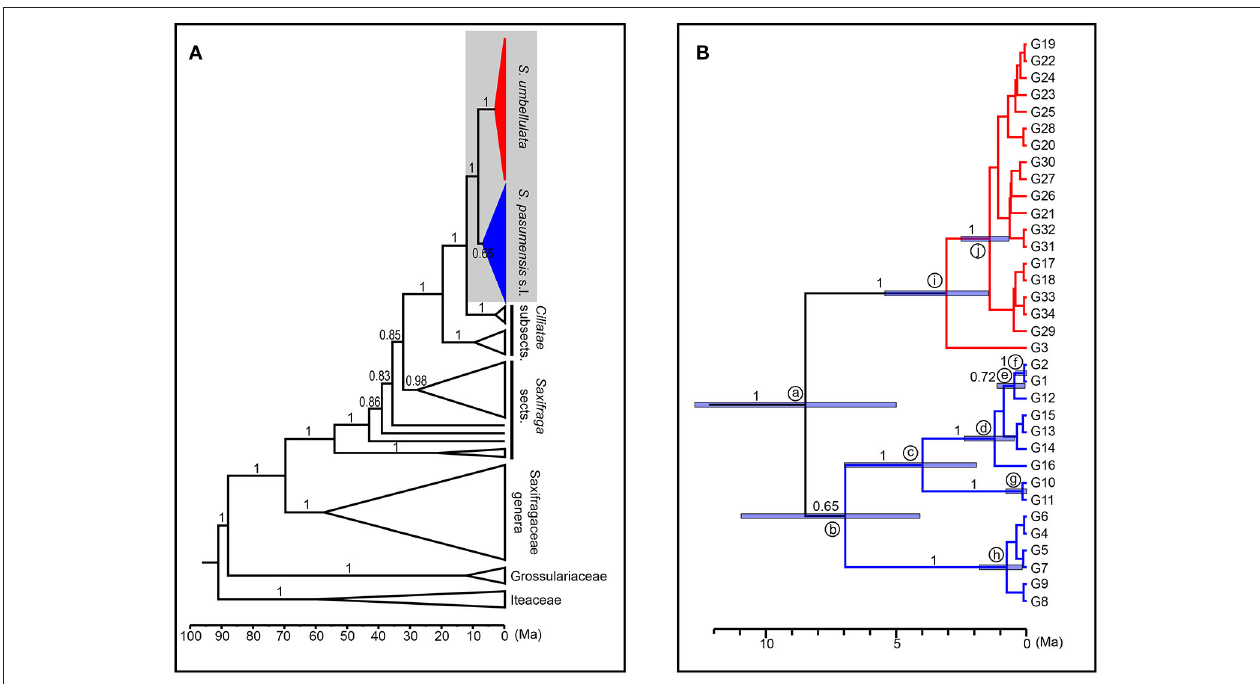
FIGURE 5 | Maximum clade credibility tree and divergence time estimation based on ITS genotypes of Saxifraga pasumensis s.l. and S. umbellulata . (A) Profile of time estimation results including all outgroups. (B) Enlargement of the shadowed area, which represents ITS genotypes of S. pasumensis s.l. and S. umbellulata . Blue bars represent 95% highest posterior density. Numbers on the branches are values of posterior probabilities.